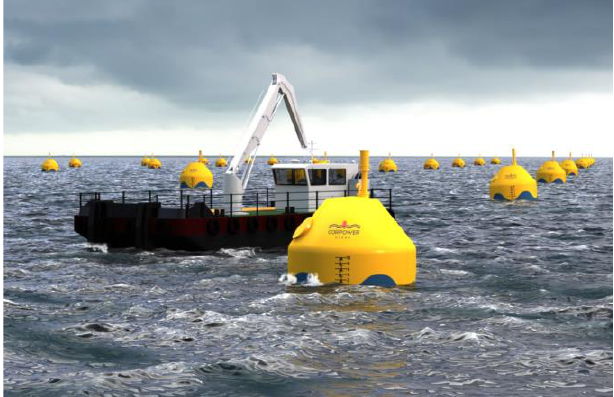
Fig. 8. Artist’s impression of CorPower’s